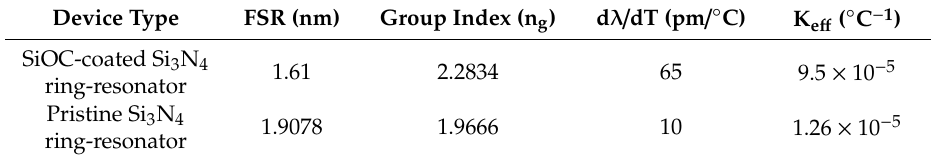
Table 1. Summary of the results of SiOC-coated Si 3 N 4 and pristine Si 3 N 4 ring